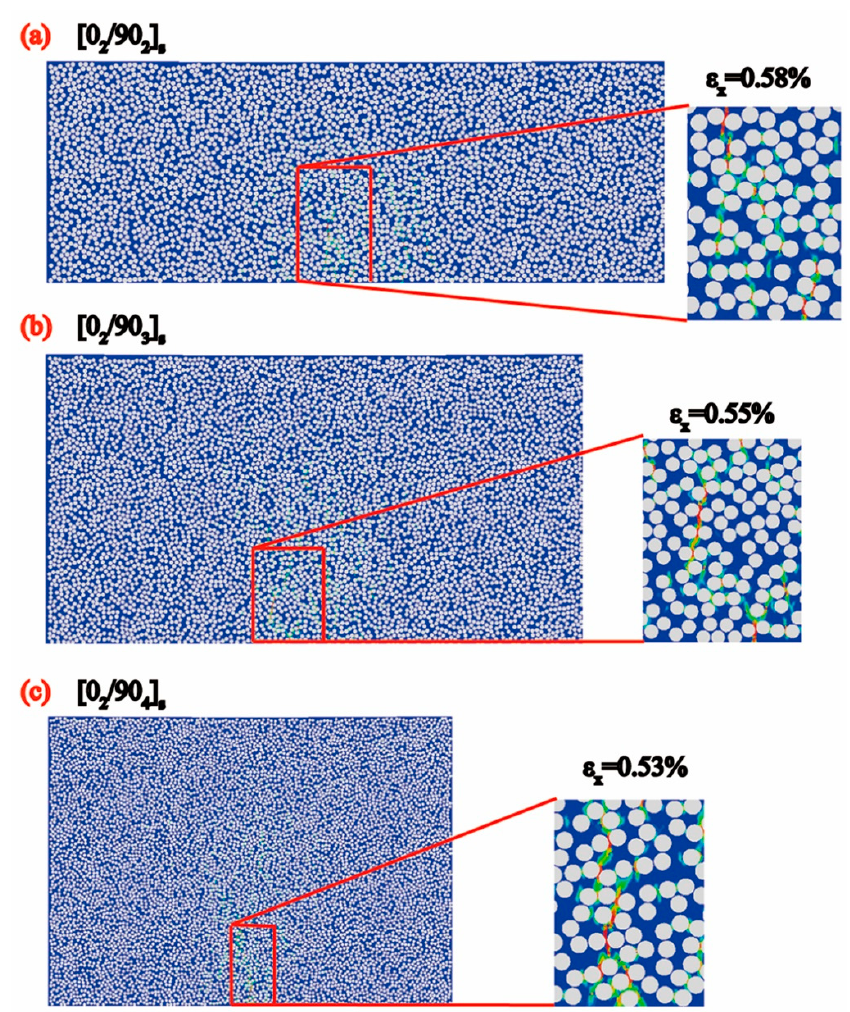
Figure 11. The simulation results of the initiation of the microcracks by the correction method of taking into account the thermal and chemical shrinkage residual stress with the applied mechanical strain along x direction in the 90 ◦ plies of the cross-ply [0 2 / 90 n ] s (n = 2,3,4) laminates. ( a ) [0 2 / 90 2 ] s laminate; ( b ) [0 2 / 90 3 ] s laminate; ( c ) [0 2 / 90 4 ] s laminate.